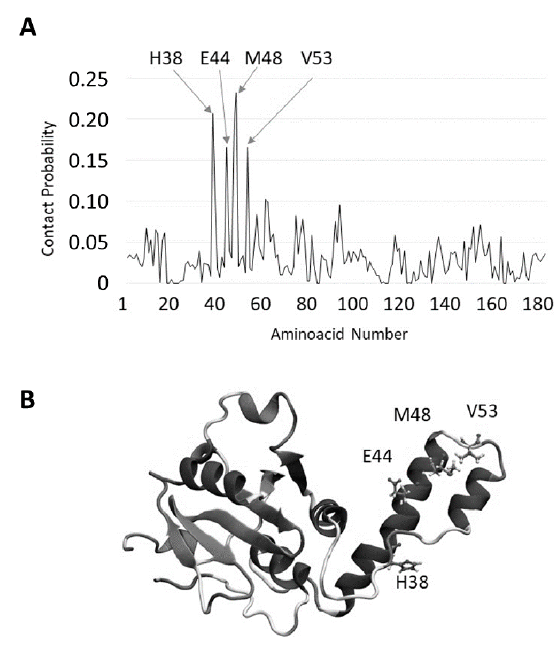
Figure 6. Searching for TFE-interacting residues of JD. ( A ) Most sampled TFE-JD binding regions identified by contact probability plot; ( B ) Picture of the most likely involved residues.